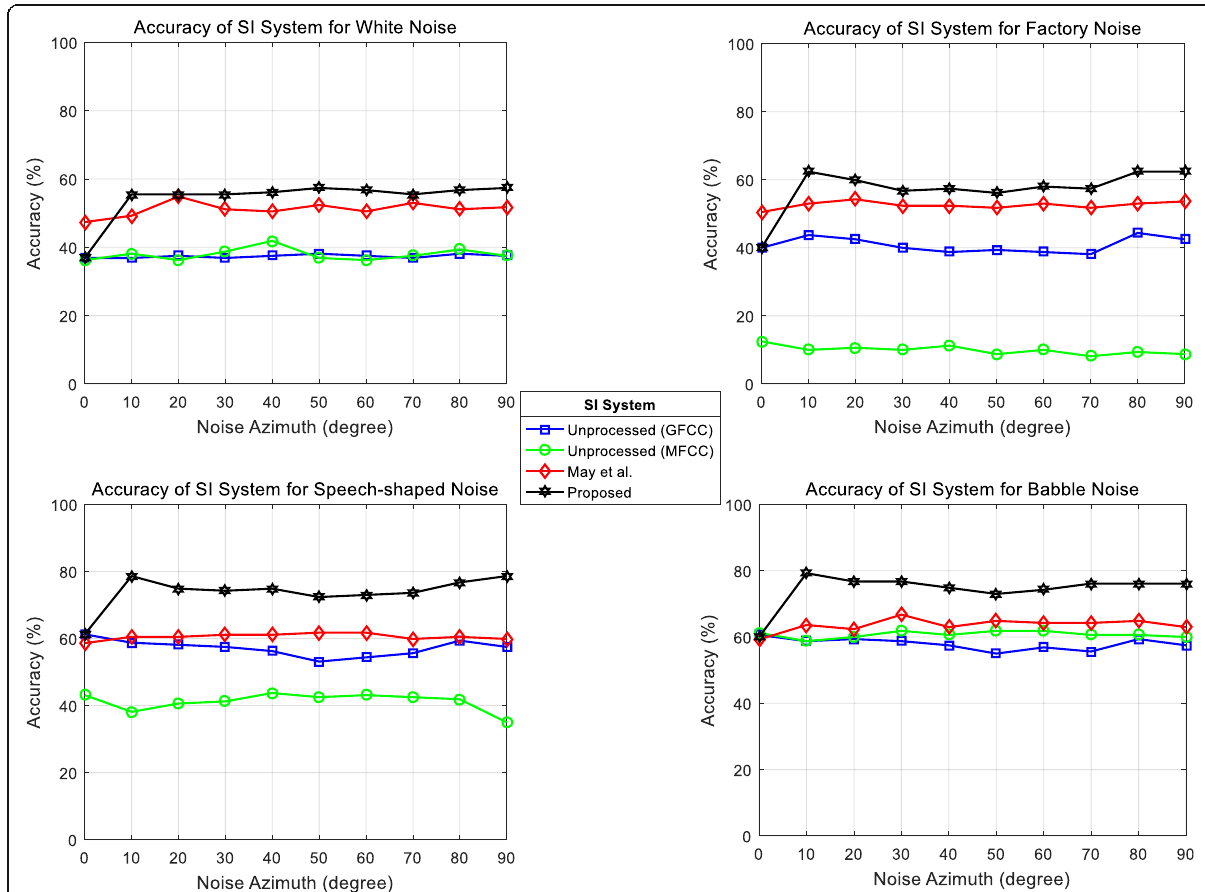
Fig. 11 The accuracy of the SI systems obtained in reverberant ( T 60 = 0.29s) and additive noise conditions with four types of noises at SNR =